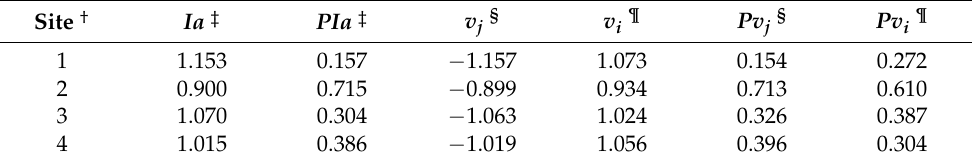
Table 3. Parameters for the spatial distribution patterns of Sphenophorus spp. larvae using SADIE at four sites in Marshallville, Georgia, in 2019 and 2020. Sites 1 and 2 were sampled in fall and winter 2019, and sites 3 and 4 spring 2020.